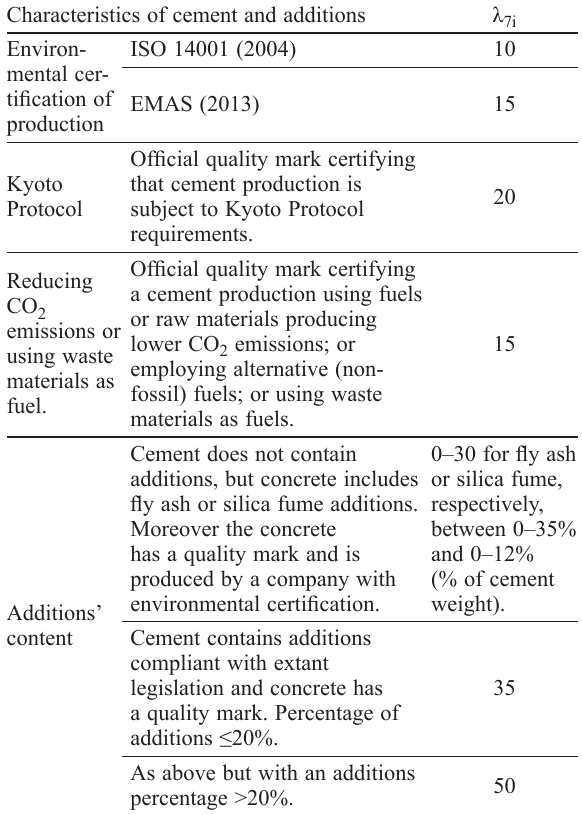
Table 2. Aspects evaluated via seventh environmental indicator from model Characteristics of cement and additions